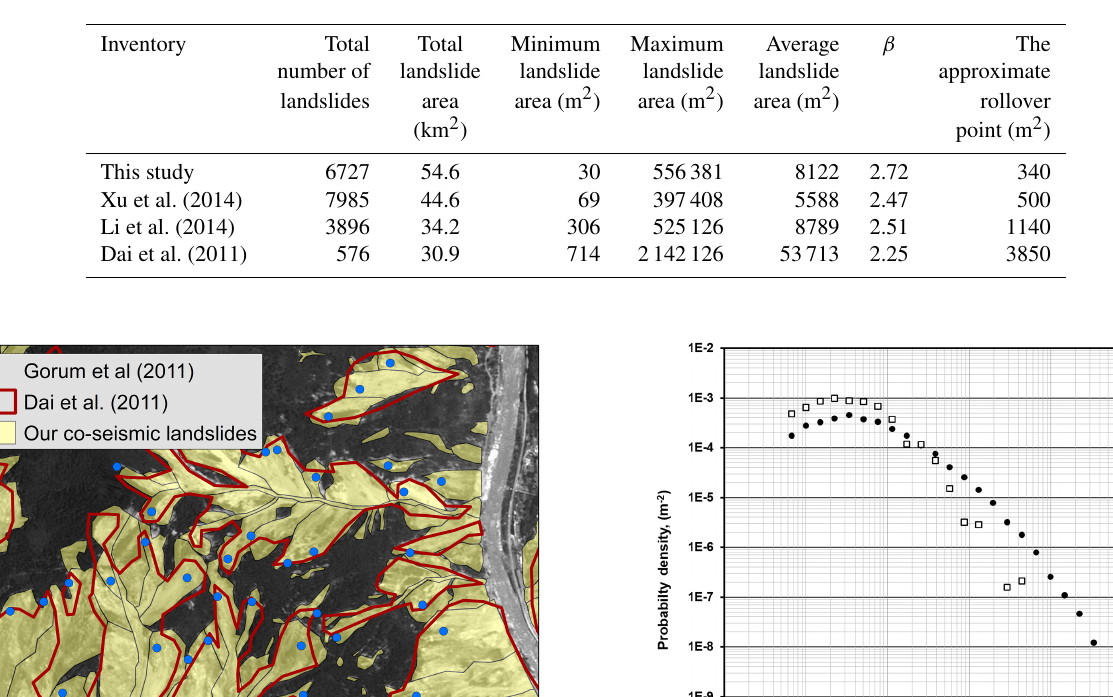
Table 5. Summary information for the co-seismic landslide inventories collected for the study area. B is the power-law exponent of the frequency–area distribution (FAD).